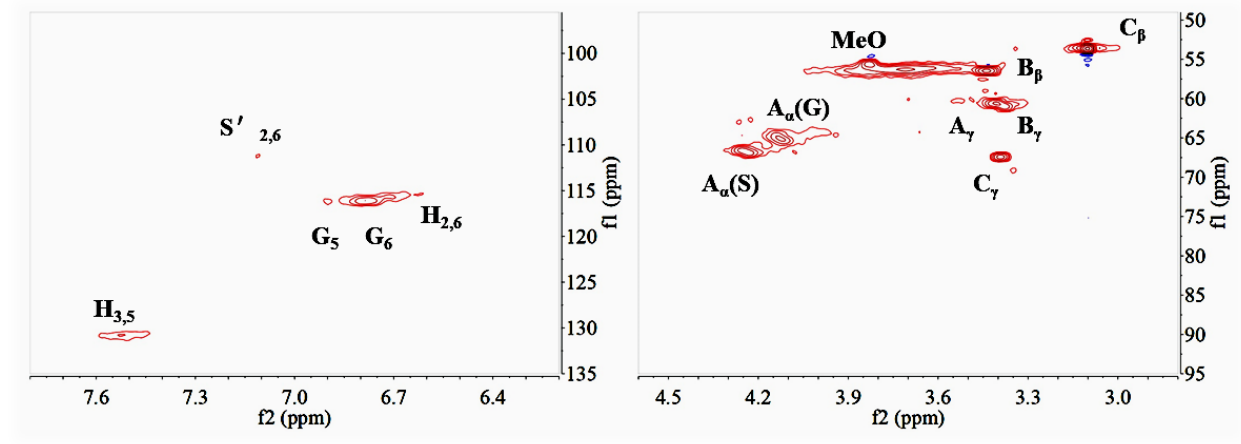
Figure 8. H−13C heteronuclear single quantum correlation (HSQC) NMR spectroscopy of R2. Figure 8. H–13C heteronuclear single quantum correlation (HSQC) NMR spectroscopy of